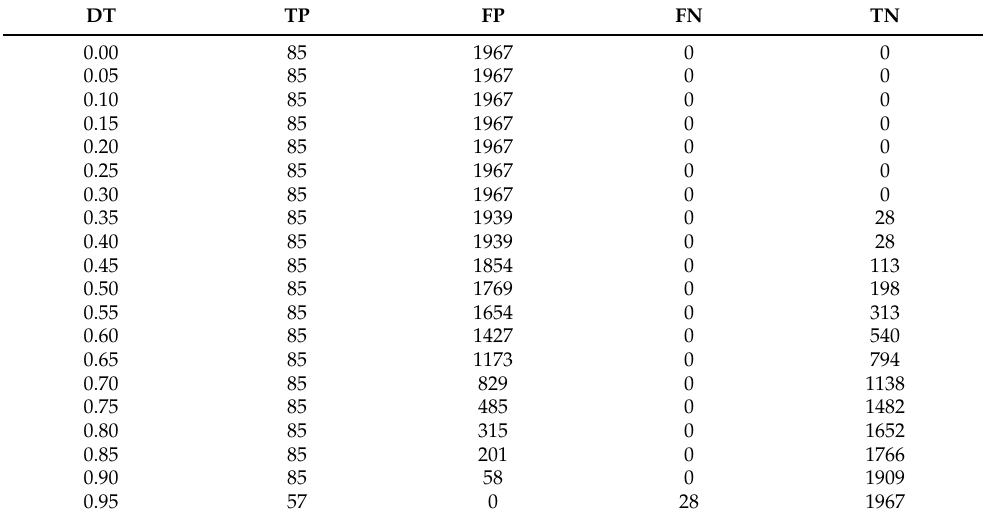
Figure 7. Decision threshold (DT) value vs. the different model indicators for the specificity ( top left ), accuracy ( top middle ), recall ( top right ), precision ( bottom left ), and F1 score ( bottom right ) metrics. The blue line corresponds to the anomaly indicator, the orange line to the normality indicator, and the green line to the ensemble indicator. Table 6. Confusion matrix of the ensemble method results with respect to the decision threshold